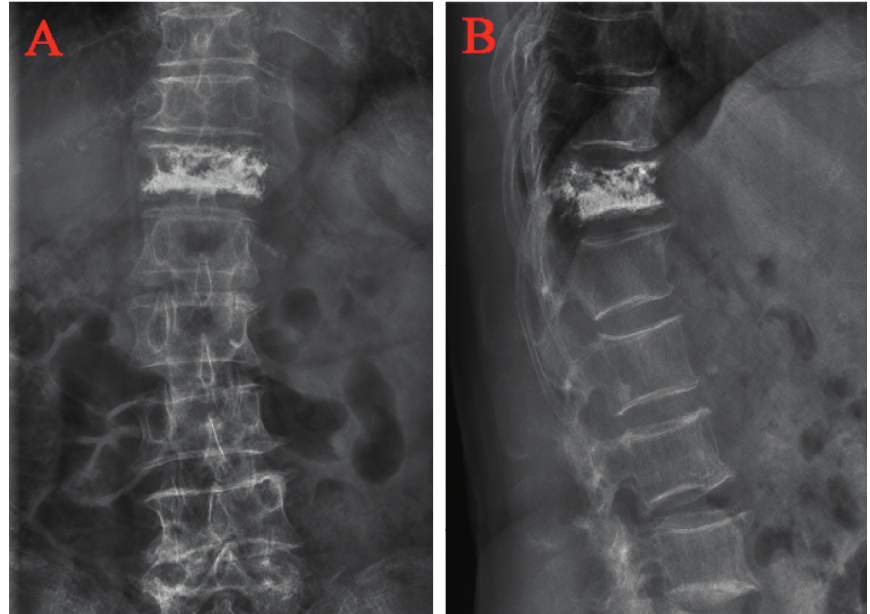
Figure 6: Distribution characteristics of blocky bone cement. (a) Anteroposterior X-ray film of local solid distribution pattern in the blocky group. (b) Lateral X-ray film of local solid distribution pattern in the blocky